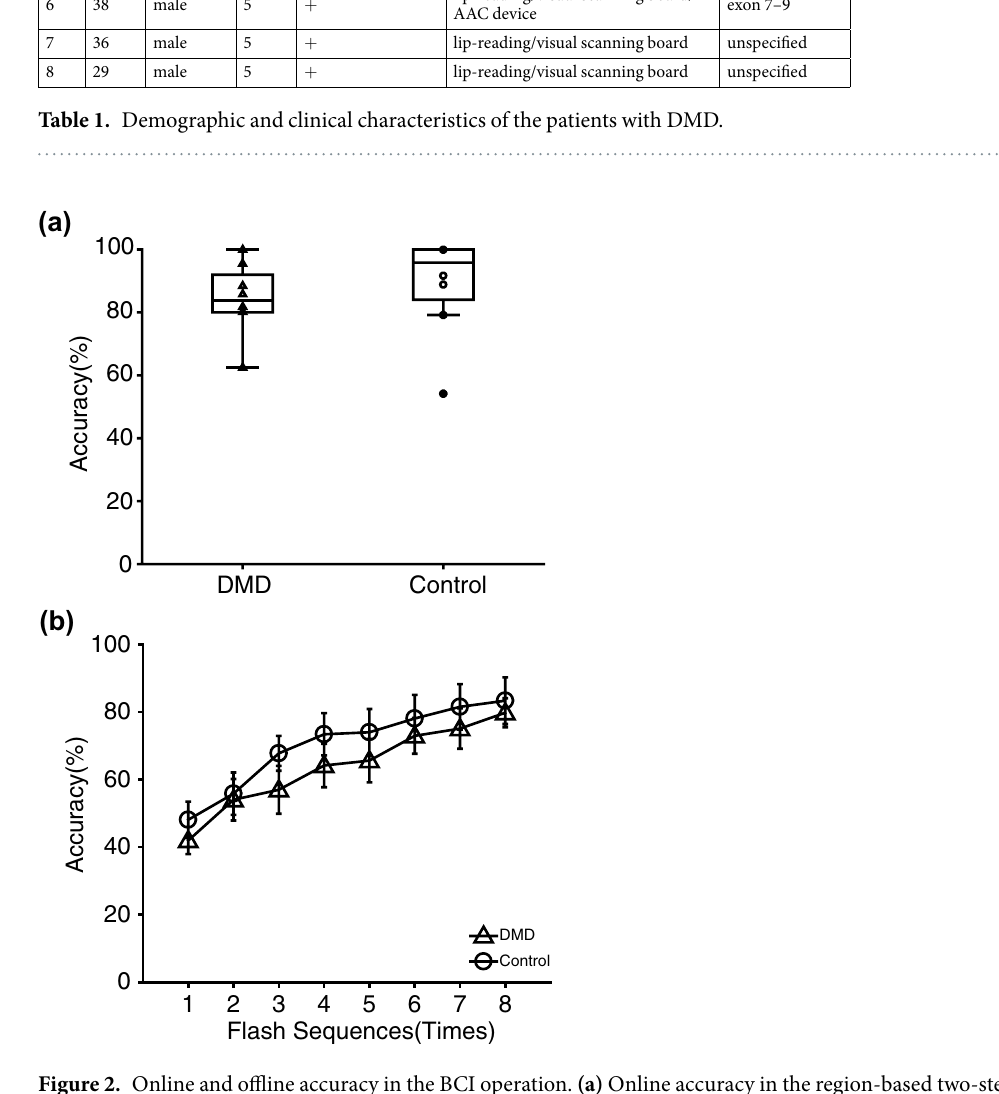
Figure 2. Online and offline accuracy in the BCI operation. (a) Online accuracy in the region-based two-step P300-BCI operation, which indicated the accuracy of both steps in total, was 79.8% for patients with DMD and 83.4% for controls; no significant difference was observed between them ( t -test, p = 0.69). Each triangle (DMD) and circle (controls) indicates each data point. (b) Offline accuracy for both groups in each flashing sequence was plotted (triangle: DMD, and circle: